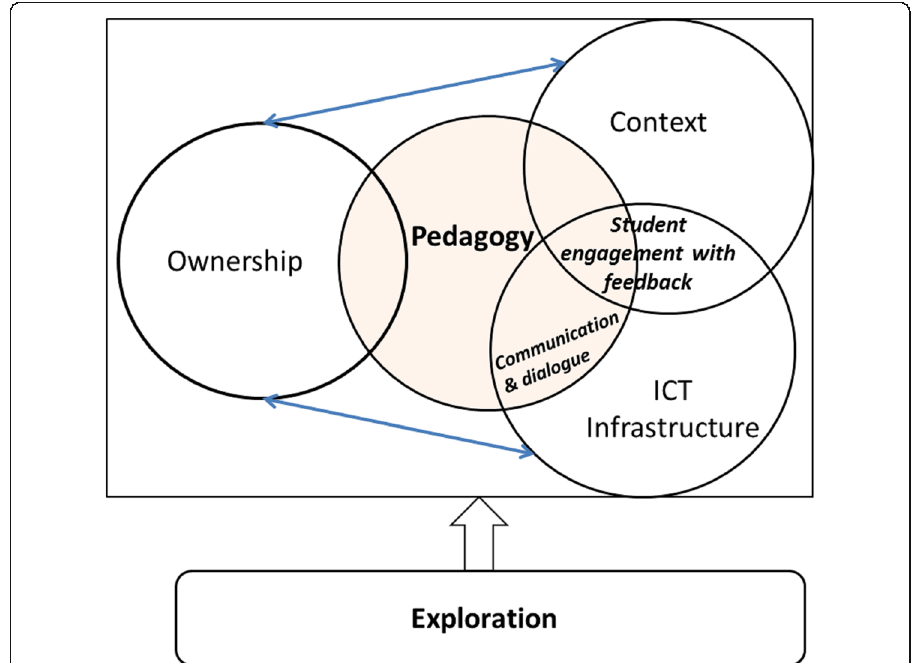
Fig. 4 Mobile Learning Framework for Assessment Feedback based on study